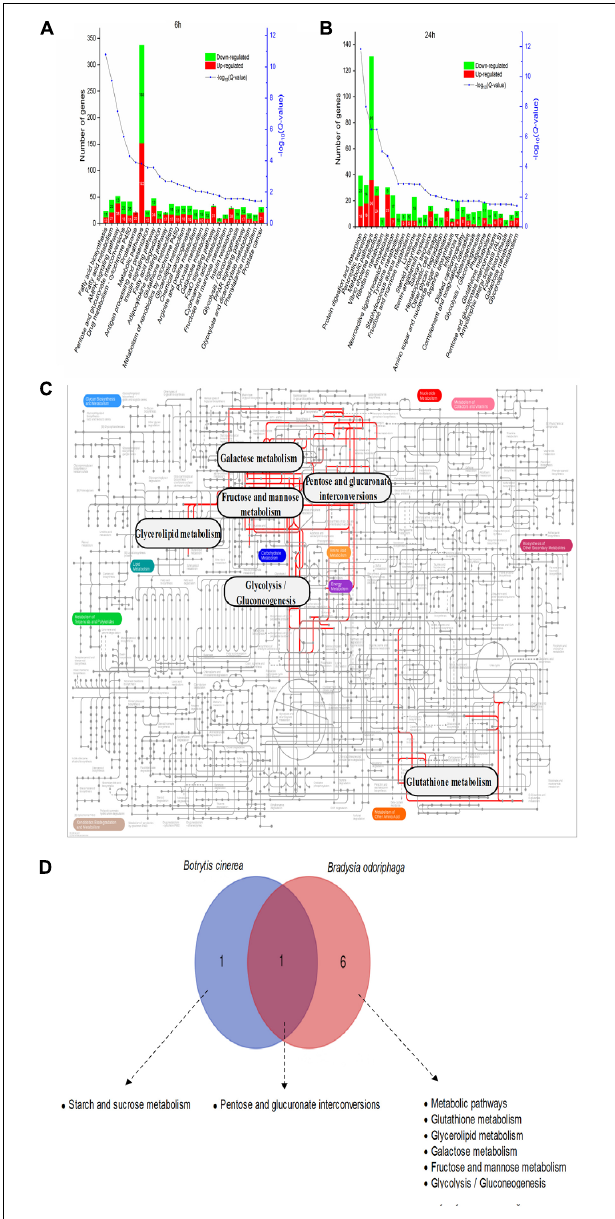
FIGURE 7 | Metabolic pathway analysis of the DEGs in Bradysia odoriphaga . (A,B) KEGG enrichment analysis of the DEGs in Bradysia odoriphaga in response to benzothiazole for 6 and 24 h. (C) Projection of the Bradysia odoriphaga transcriptome on the KEGG pathways using iPath (Letunic et al., 2008). The common significantly changed pathways shared in the 6- and 24-h groups are shown with red lines. (D) Shared and different pathways between Botrytis cinerea and Bradysia odoriphaga . A Venn diagram was drawn using the data from Figure 5B (common pathways shared at 24 and 48 h in Botrytis cinerea ) and Figure 7B (common pathways shared at 6 and 24 h in Bradysia odoriphaga ).